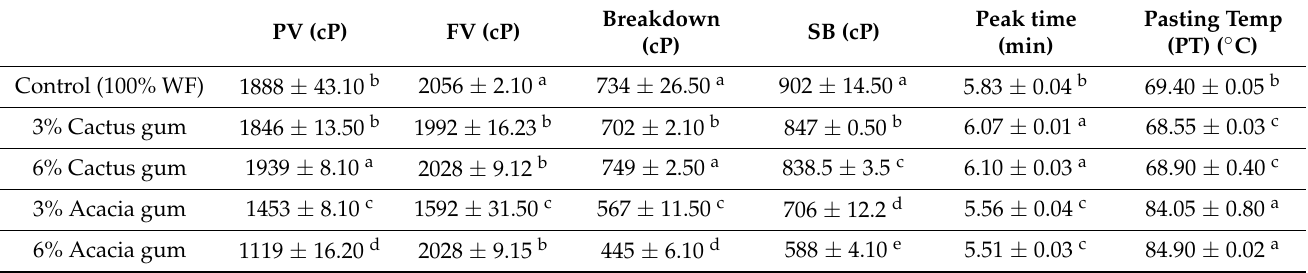
Table 1. Pasting properties of flour gum